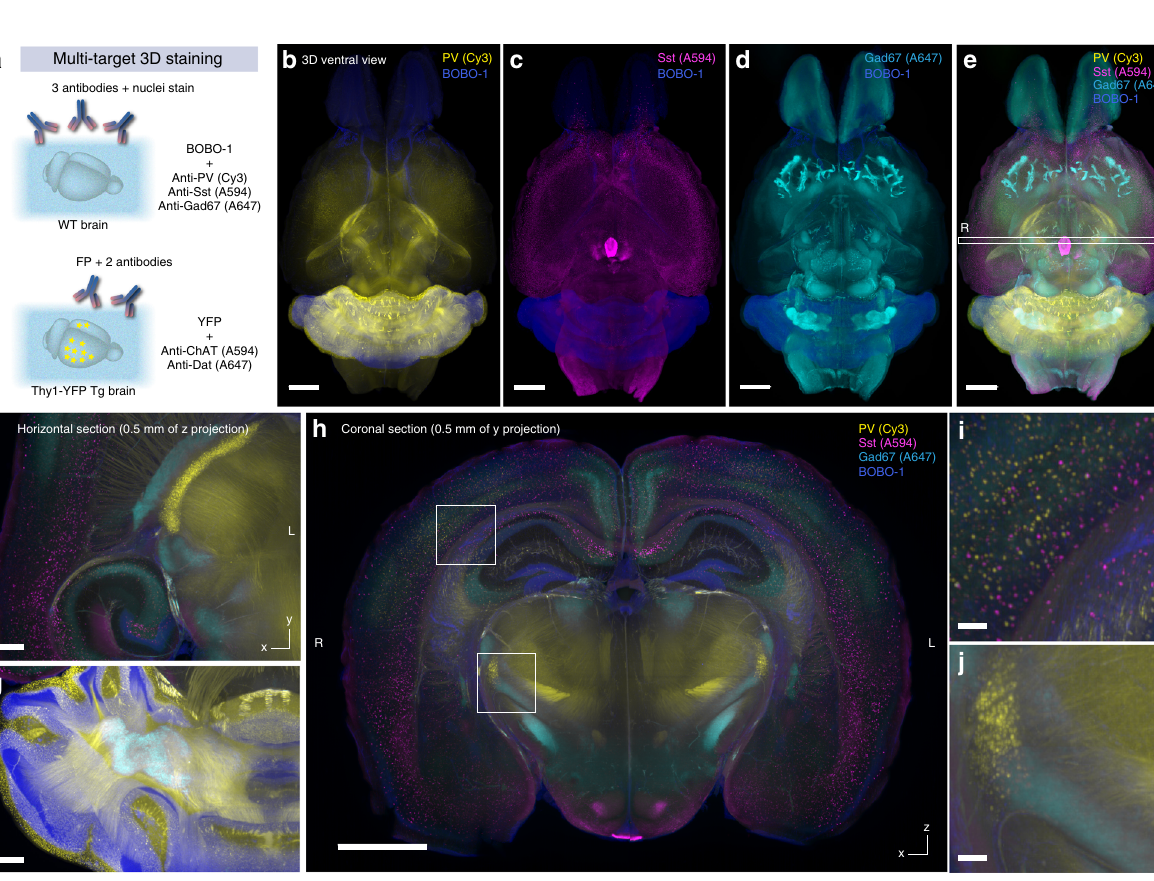
Fig. 5 CUBIC-HV enables multicolor whole-organ staining and imaging. a Experimental schematics of multichannel and multimodal whole-brain staining and imaging, shown in Figs. 5 and 6. b – j BOBO-1, PV (Cy3), Sst (A594), and Gad67 (A647) quadruple costaining images of the sole whole adult mouse brain reconstituted with Imaris software. ( b - d ) Individual antibody staining channels alongside the BOBO-1 channel. Voxel size 8.3 × 8.3 × 9 μ m 3 . Scale: 2 mm. e Merged image of all four channels. Scale: 2 mm. f , g Enlarged horizontal ( x – y ) images of a representative section. Scale: 0.5 mm. h Reconstituted coronal ( x – z ) section image at the position indicated in e . Scale: 2 mm. i , j Enlarged images of the indicated positions in h . Scale: 0.1